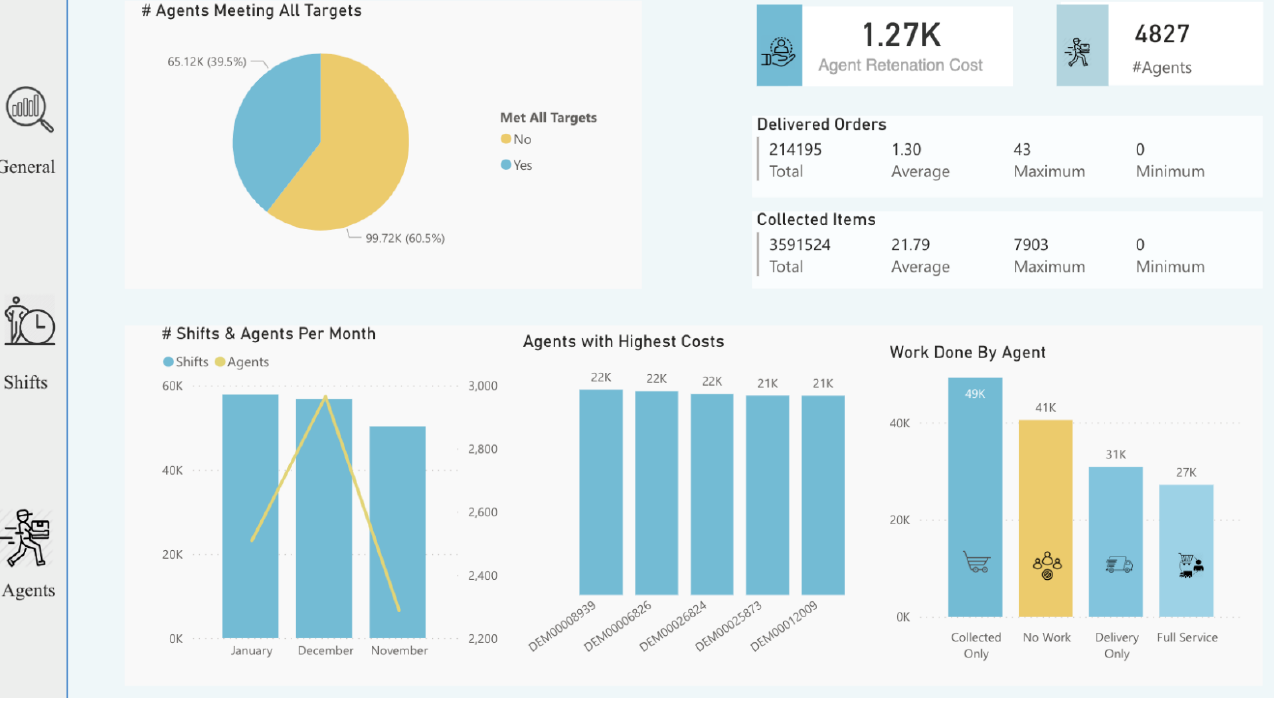
Figure 13. Dashboard (agents tab) designed after analysis.